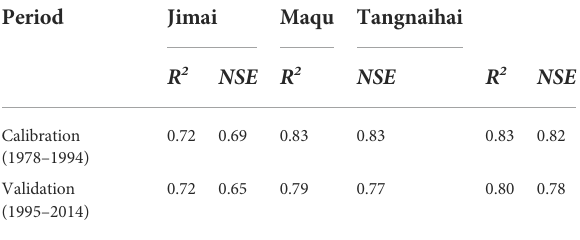
TABLE 4 Statistical values between simulated and measured data for monthly discharges in the three hydrological stations. Period Jimai Maqu